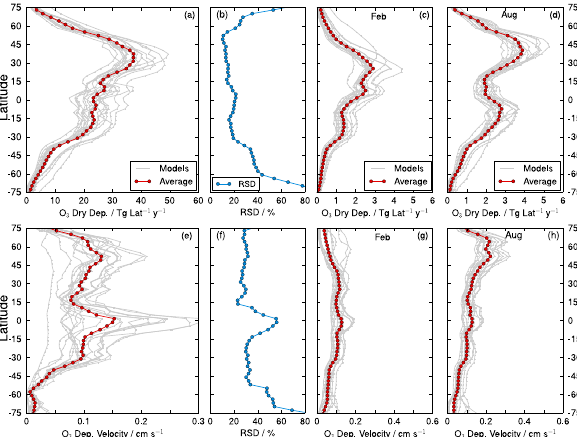
Figure 2. Latitudinal distribution of total O 3 dry deposition (top row) and average O 3 deposition velocities (bottom row) per 3 ◦ lat- itude band for the model ensemble. Panels show the total annual O 3 dry deposition and average annual O 3 dry deposition velocity (a, e) , the relative standard deviation (RSD) in annual deposition and average annual deposition velocity across the models (b, f) , and the total monthly O 3 dry deposition fluxes and average annual dry deposition velocities in February (c, g) and August (d, h)